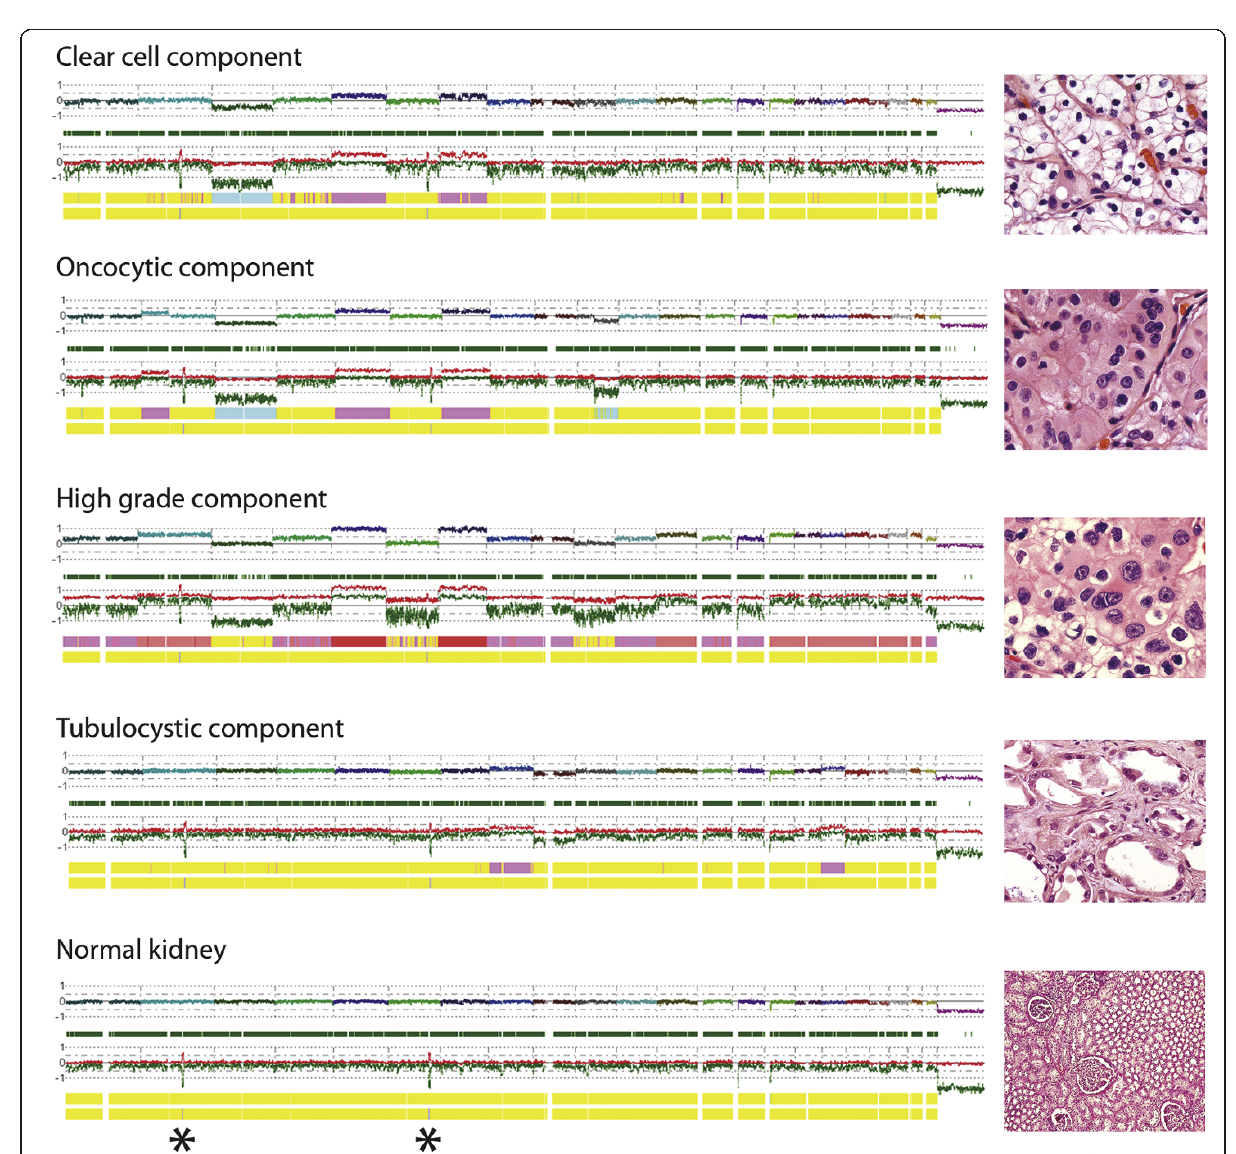
Figure 5 Genomic profile of tumor components . The uppermost plot for each sample represents the estimated copy number as a log 2 ratio averaged over 30 SNPs; middle bar represents a color-coded Hidden Markov Model (HMM) for copy number (yellow = copy number 2, pink = copy number 3, aqua = copy number 1), and bottom bar is a color-coded HMM for LOH (yellow = no LOH, blue = LOH). Genomic analysis revealed loss of chromosome 3p and gains in chromosomes 5 and 7 in all ccRCC components, a gain of 2p and loss of 10q in the oncocytic component, and a profile consistent with polyploidy (likely trisomic) with additional gains and losses in the high-grade component. The tubulocystic component showed a profile distinct from that of ccRCC. Germline uniparental disomy (UPD) of chromosomes 2 and 6 [UPD2 (q21.3-q22.1), UPD6 (q23.2-q23.3)] (asterisks) was found in all (tumor and normal) specimens from the